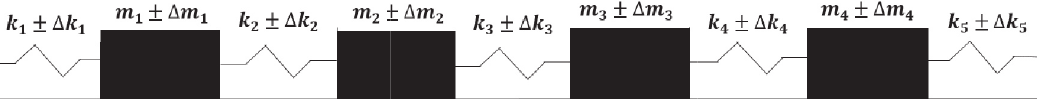
Fig. 6. Schur stability.